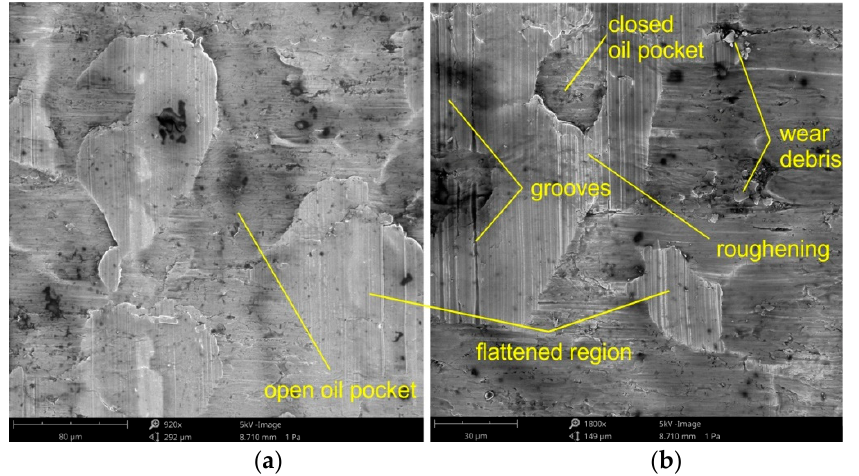
Figure 19. The specimen surfaces tested in dry friction (Ra = 0.32 µ m, h = 6 mm, w = 14 mm, orientation 90 ◦ ) at different magnifications: ( a ) × 920 and ( b ) ×